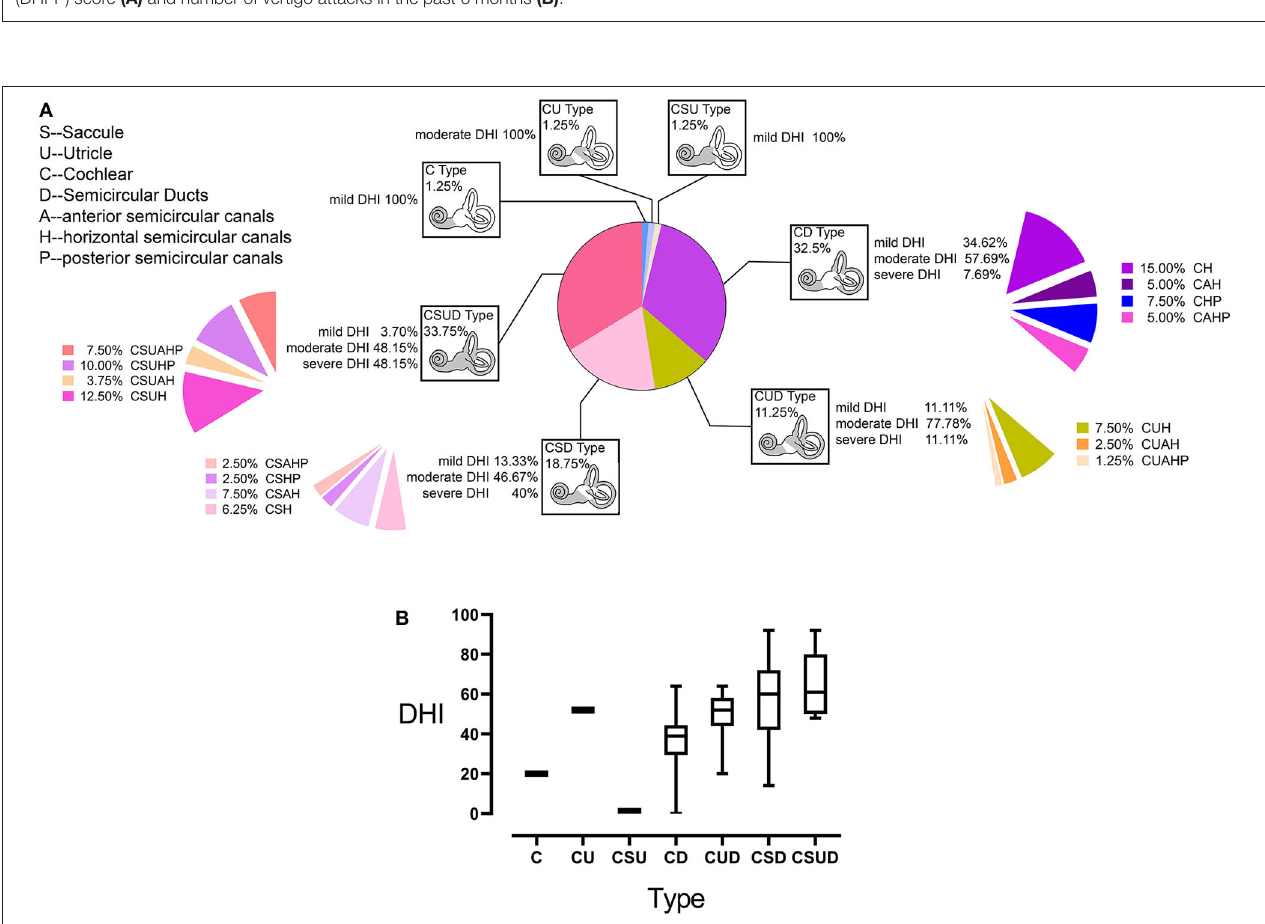
FIGURE 6 | Categorization of study participants with Menière’s disease (MD) based on the involved parts of the inner ear (A) . The involvement of the cochlea was labeled as the C (cochlea) type pathology in all subjects. Similarly, the involvement of the saccule, utricle, and semicircular canals (SCs) was labeled as the S-, U-, or D-type pathology, respectively. In the D type, the involvement of a specific SC was labeled by the suffix H, P, and A for H-SC, P-SC, and A-SC, respectively. The type and percentage of participants for each type out of the total study population are presented inside each box. The percentages of participants with each Dizziness Handicap Inventory (DHI) level relative to the total population of this type are listed beside each box. Moreover, the patients with the involvement of different SCs are listed as percentages out of the total sample. Except for three types with only one patient, DHI score and the number of the involved vestibular end organs are increased clockwise (B) ; the range of error bars is the expression of 95% confidence interval.